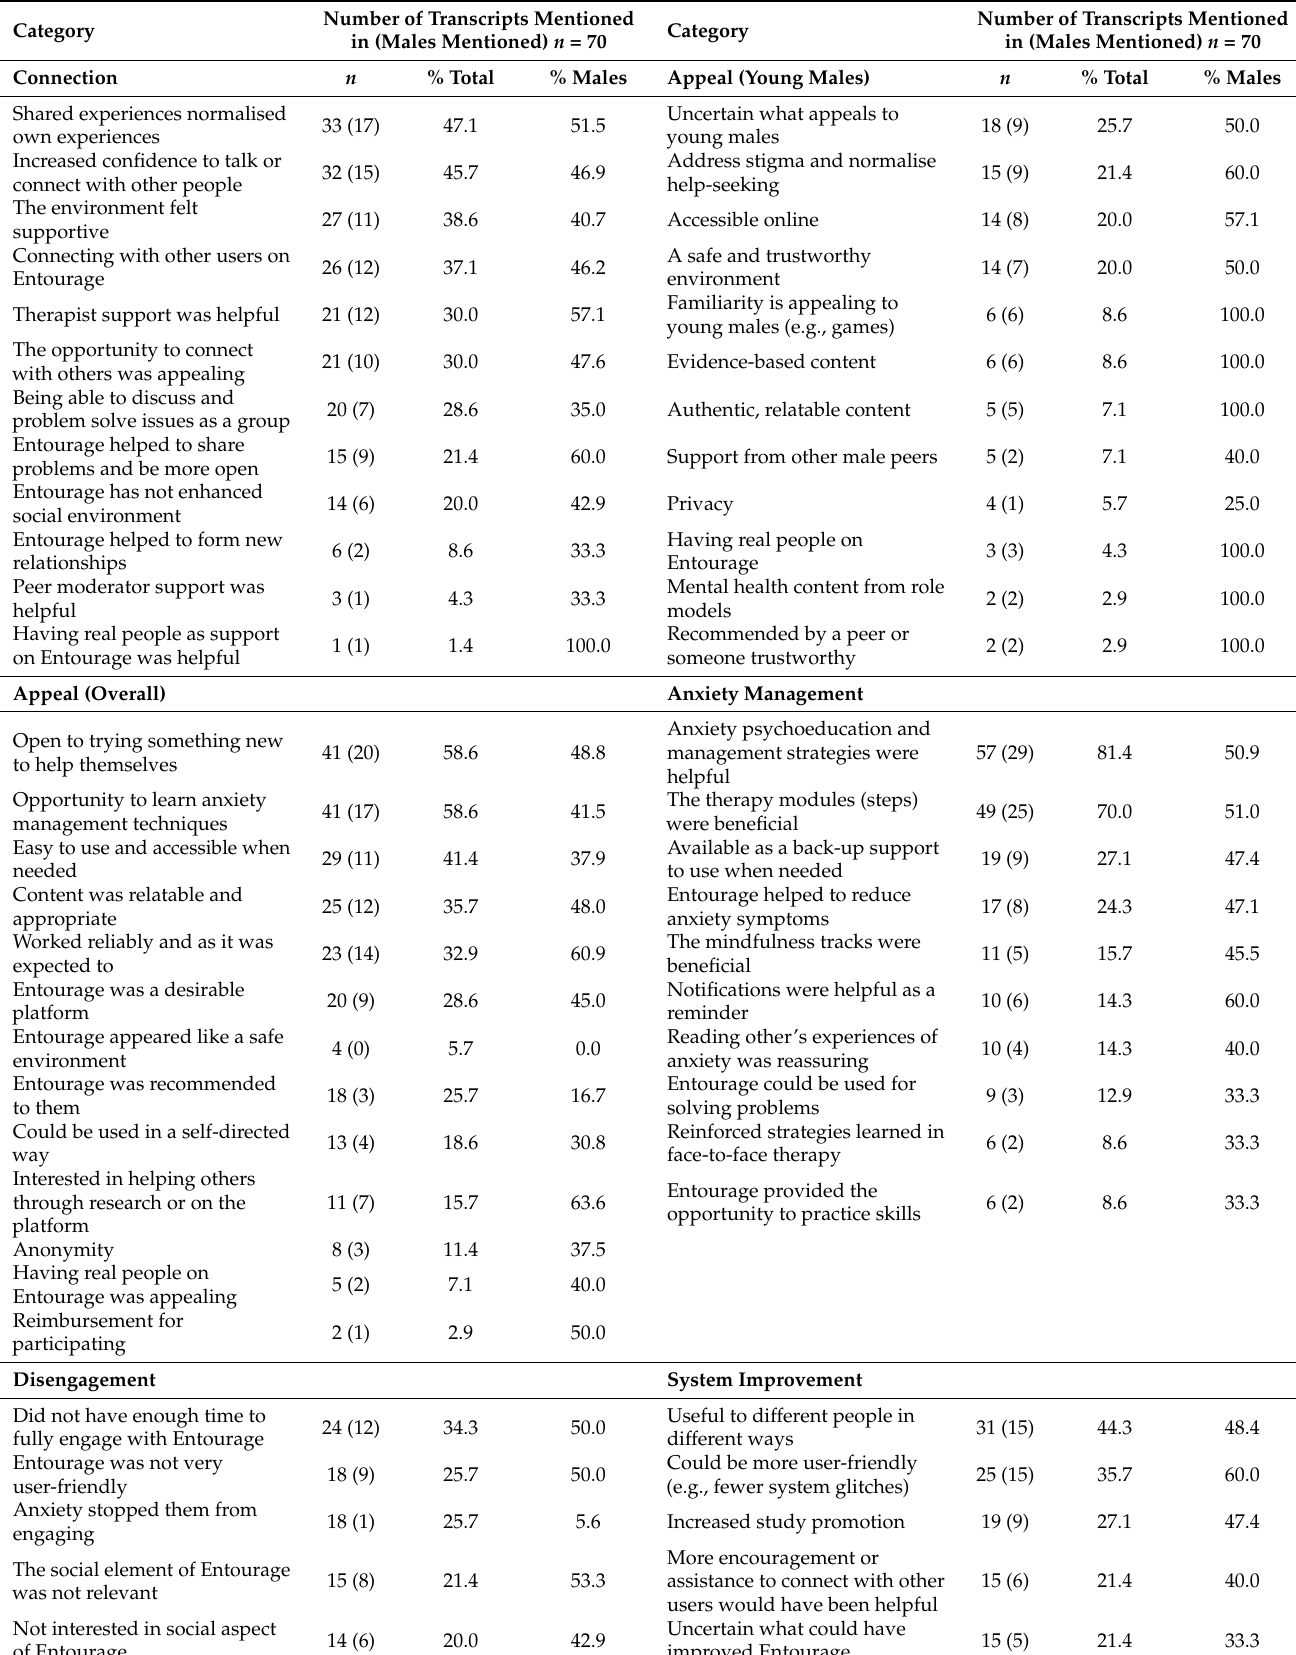
Table 2. Summary of Participant Experiences of Using the Entourage